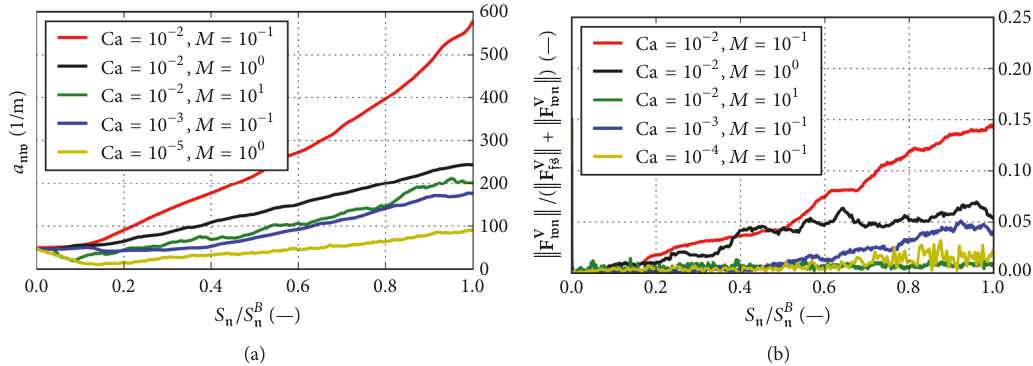
Figure 4: (a) Evolution of specific fluid-fluid interfacial area 𝑎 wn in microstructure C. (b) Ratio of total interfacial viscous force to total resistance force in microstructure C. Data are presented as a function of normalized NWP saturation where 𝑆 𝐵 n denotes NWP saturation at